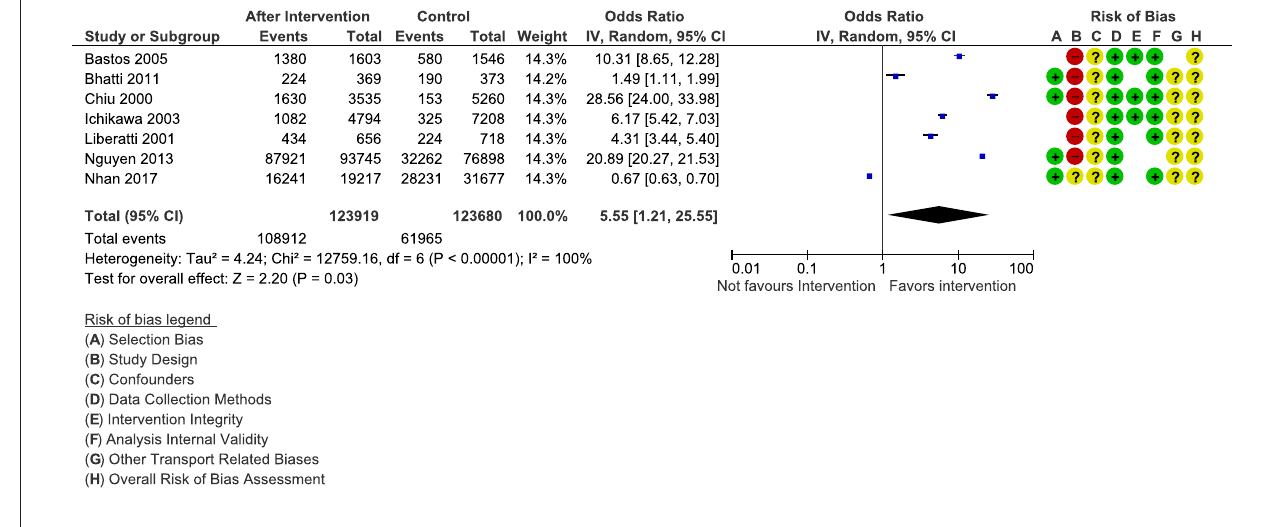
FIGURE 8 | Secondary outcome: changes in helmet use ‘compliance’ after mandatory helmet law enforcement.